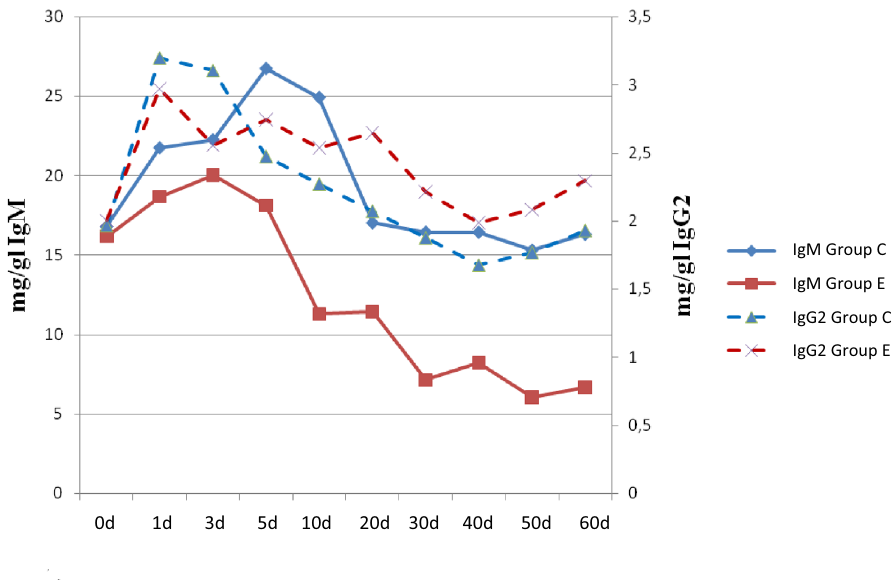
Figure 2. Influence of immunization on IgM and IgG2 concentration. 0d—sample collected at delivery; 1d—sample collected 24h after delivery; 3d—sample collected 3rd days of life; 5d—sample collected 5th days of life; 10g—sample collected 10th days of life; 20d—sample collected 20th days of life; 30d—sample collected 30th days of life; 40d—sample collected 40th days of life; 50d—sample collected 50th days of life; 60d—sample collected 60th days of life Group C—control group; Group E—experimental group stimulated multi-component bacterial immunomodulator (injection in 35th and 40th days after delivery). IgG2 means at 30th, 40th, 50th and 60th days of life show significant differences with Kruskal-Wallis test ( p <0,05). IgG2 means at 3rd and 20th days of life show highly significant statistical differences Kruskal-Wallis test ( p <0,01). IgM means at 5th days of life show significant differences with Kruskal-Wallis test ( p <0,05). IgM means at 30th, 40th, 50th and 60th days of life show highly significant statistical differences Kruskal-Wallis test ( p